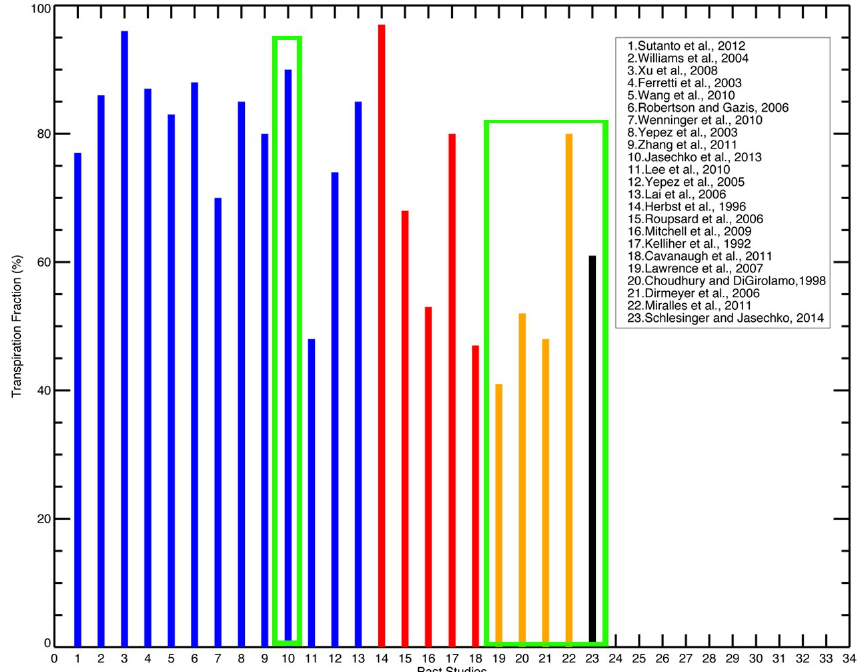
Figure 1. Transpiration fraction from several past partitioning studies. The plot shows maximum values of transpiration fraction from those studies. Blue is for isotope-based methods, red is for hydrometric methods, orange is for global land-surface model results, and black is a combination hydrometric and model result. The studies inside the green boxes present global average